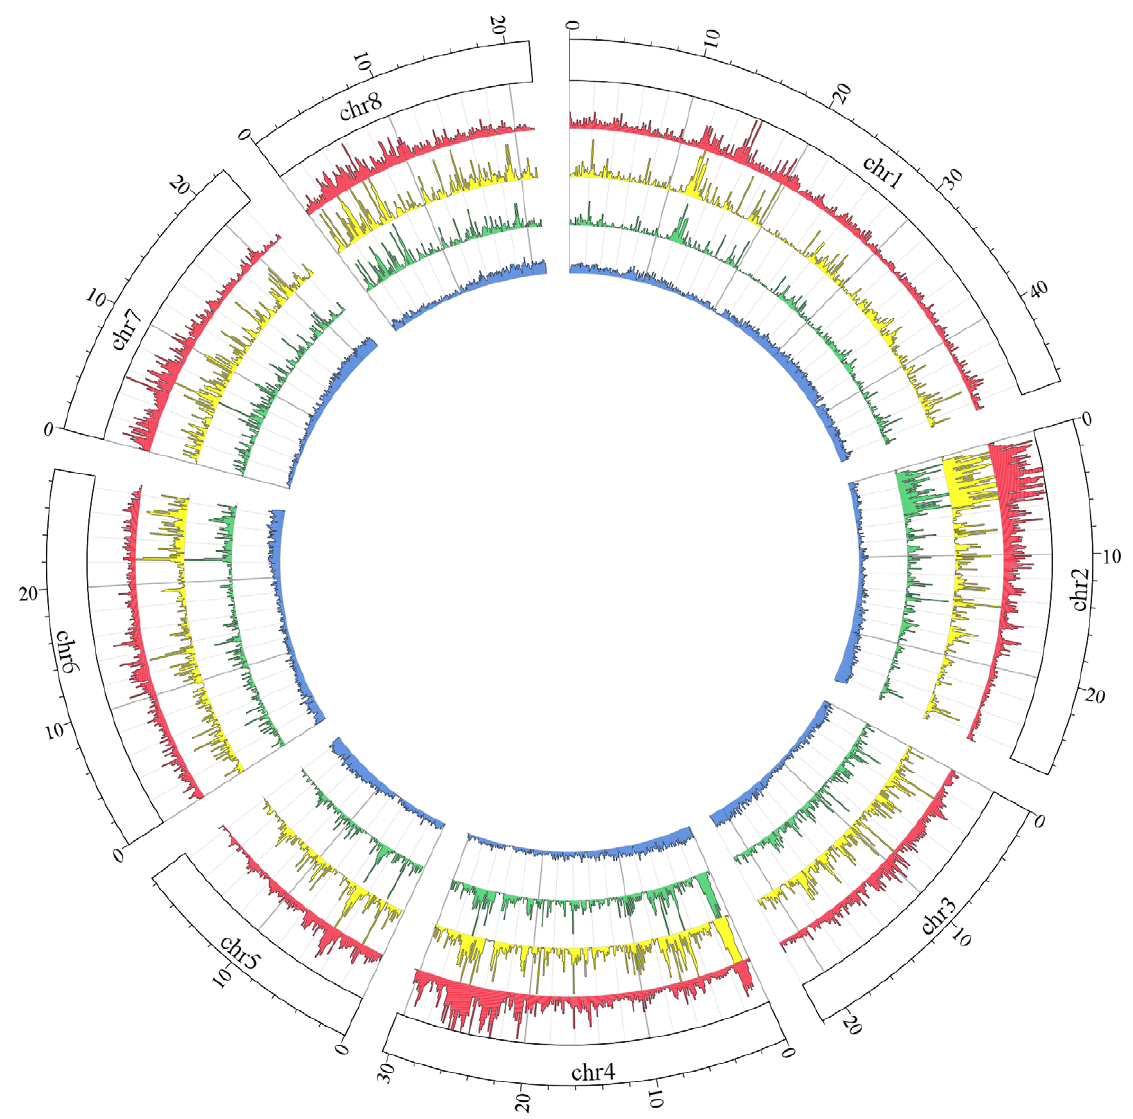
Figure 2. Distribution of SNPs along the Peach v1.0 pseudomolecules. All tracks are plotted in 100 kb windows; inner blue track represents the frequency of coding DNA sequence CDS; y axis ranges from 0 to 100%. Red, yellow and green tracks represent, respectively, absolute number